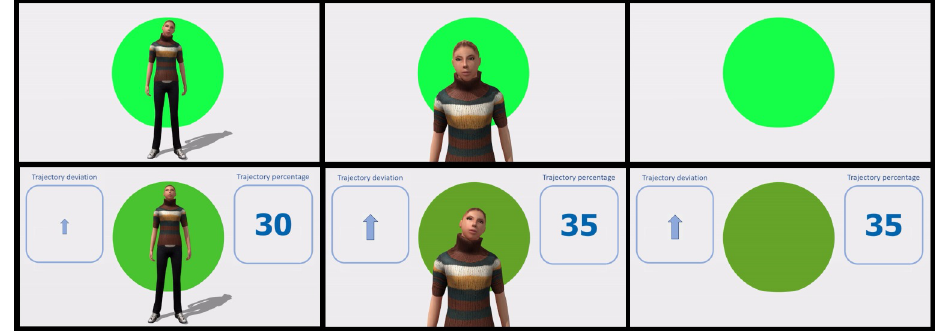
Figure 2. Six tested user